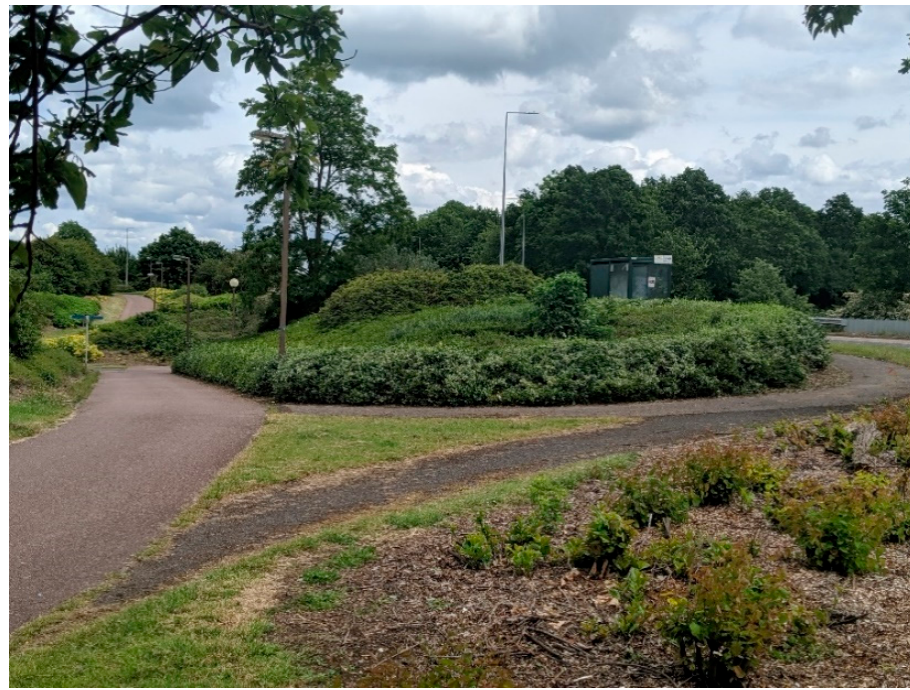
Figure 8. A Redway/path connecting to a bus stop on the grid system in the Kent’s Hill District of Milton Keynes. Permission granted by Marston.